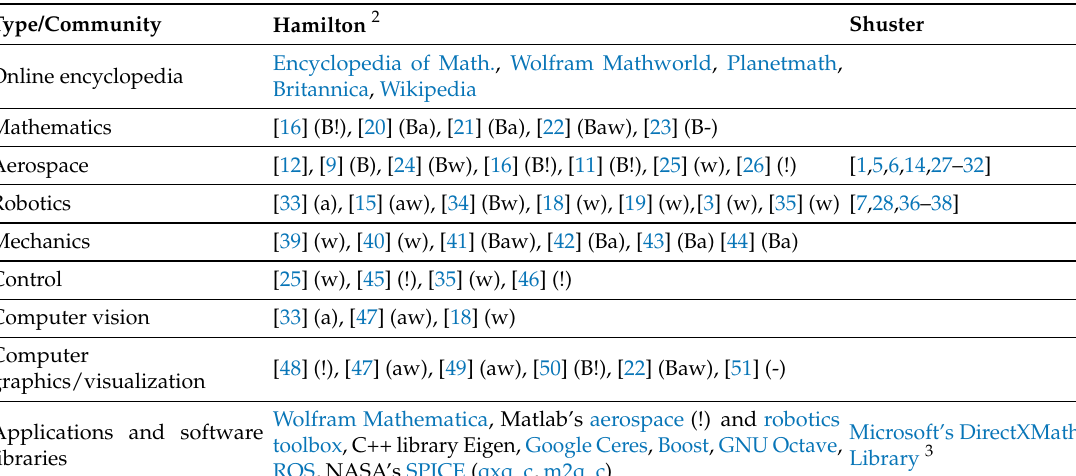
Table 1. Popularity of the two multiplications 1